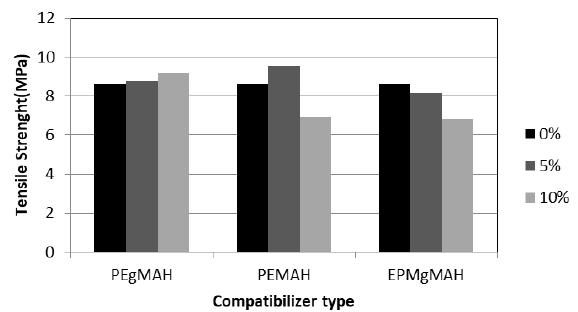
Figure 2: Tensile strength values of the prepared r-LDPE/TPS based blends.